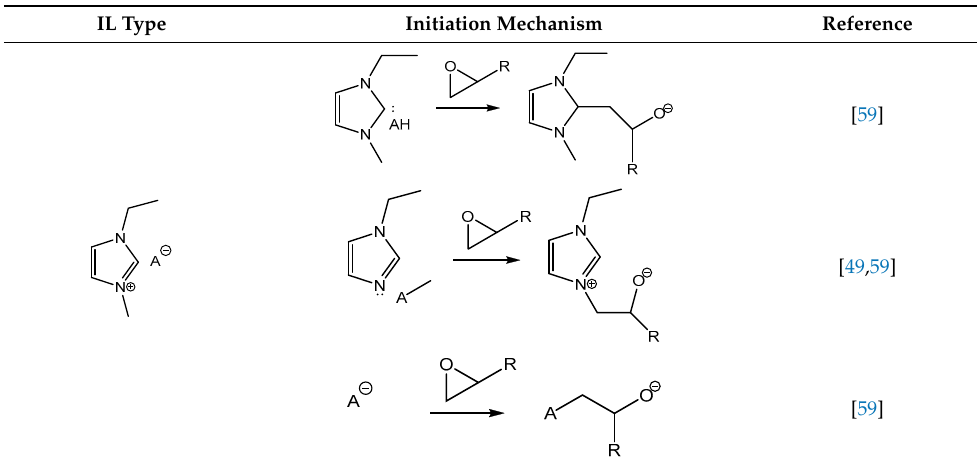
Table 1. Proposed initiation mechanisms for curing epoxy resins using ILs. IL Type